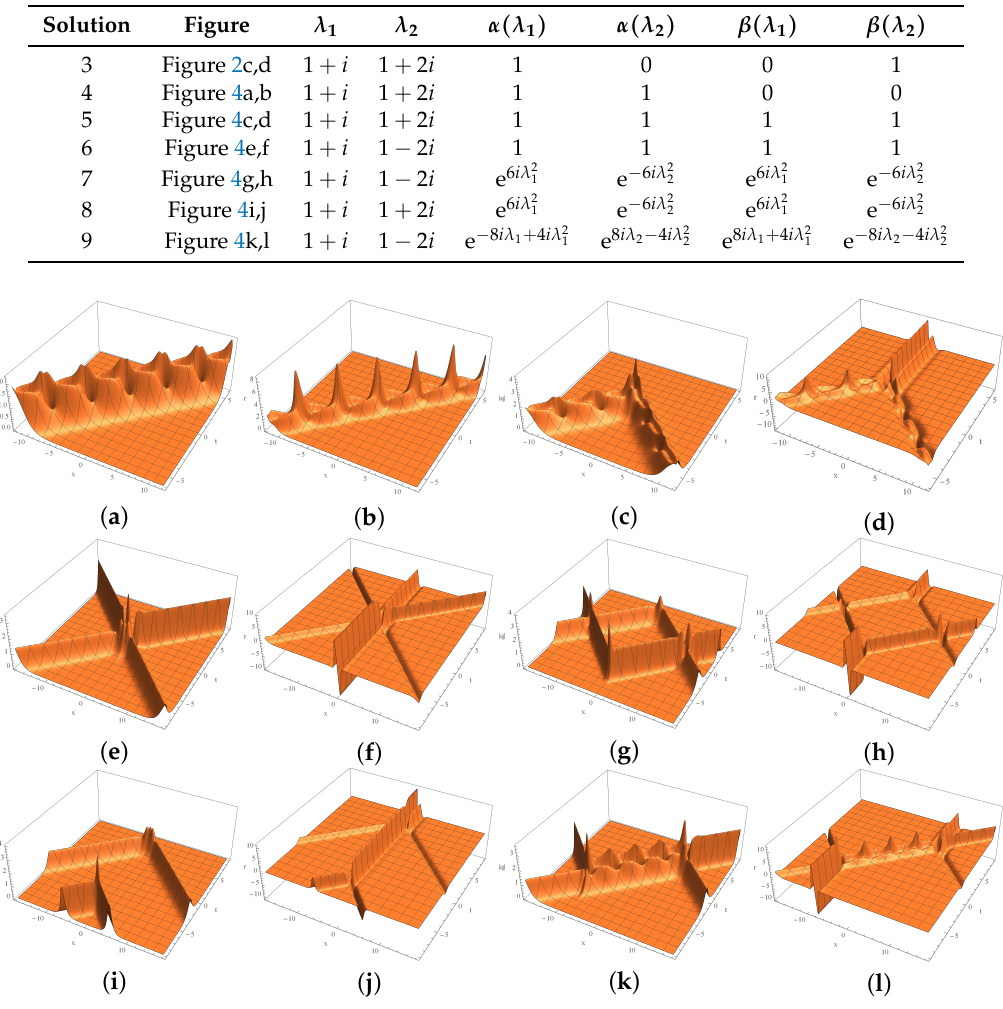
Figure 4. Some nonlinear